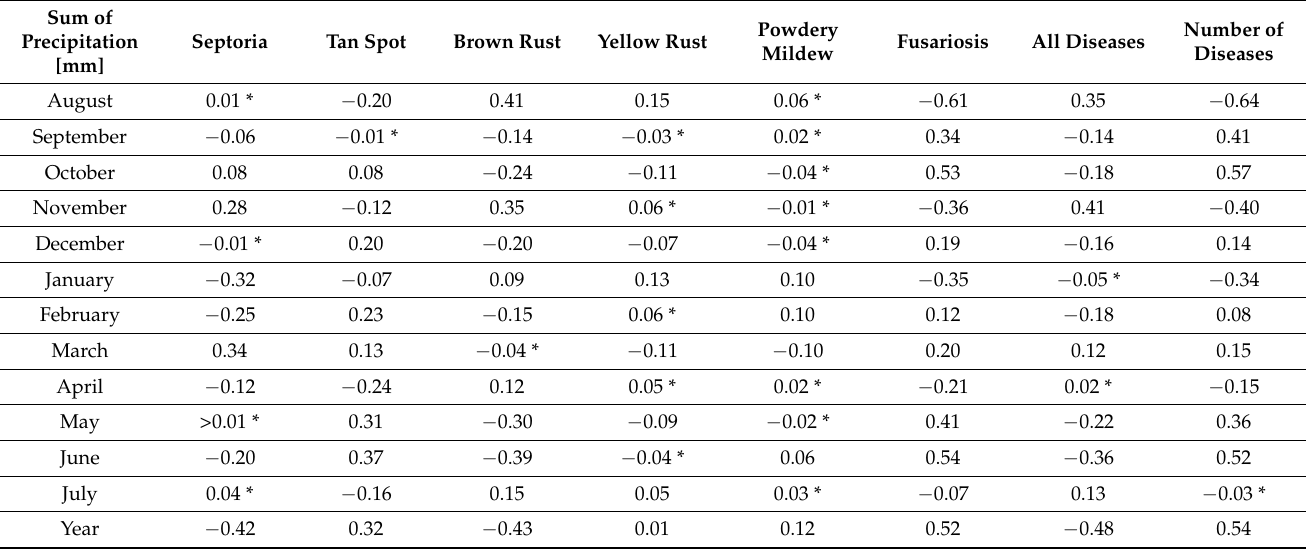
Table 4. Pearson’s linear correlation between sums of precipitation and wheat foliar disease infesta- tion.